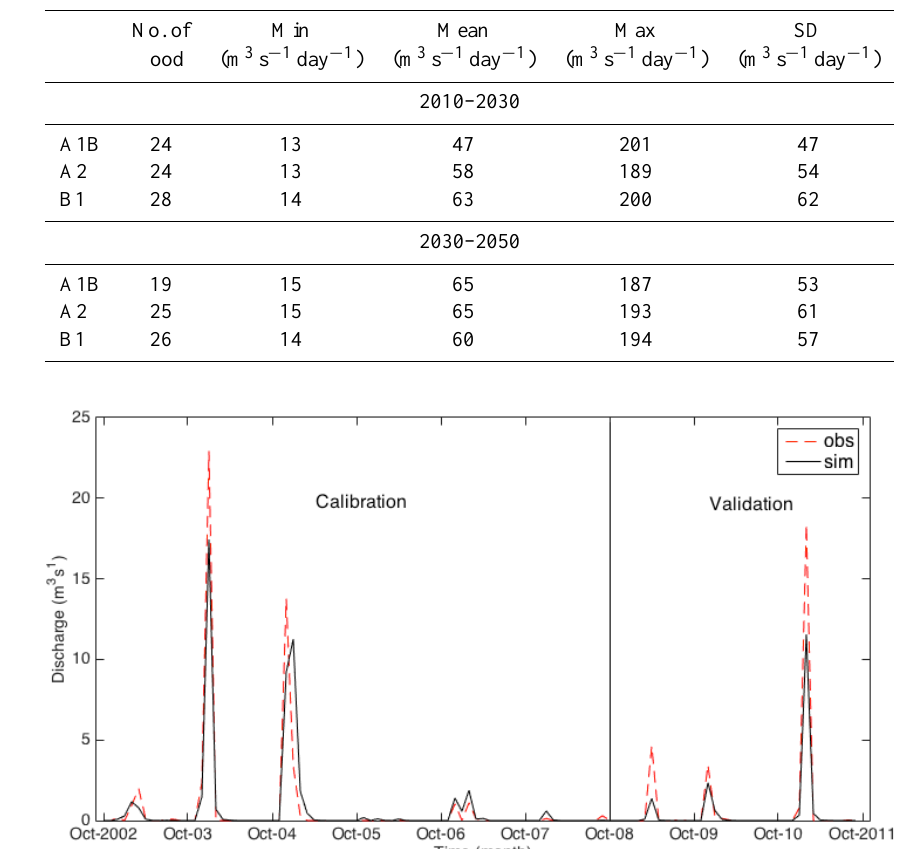
Table 1. Summary statistics of projected runoff for the periods 2010–2030 and 2030–2050.